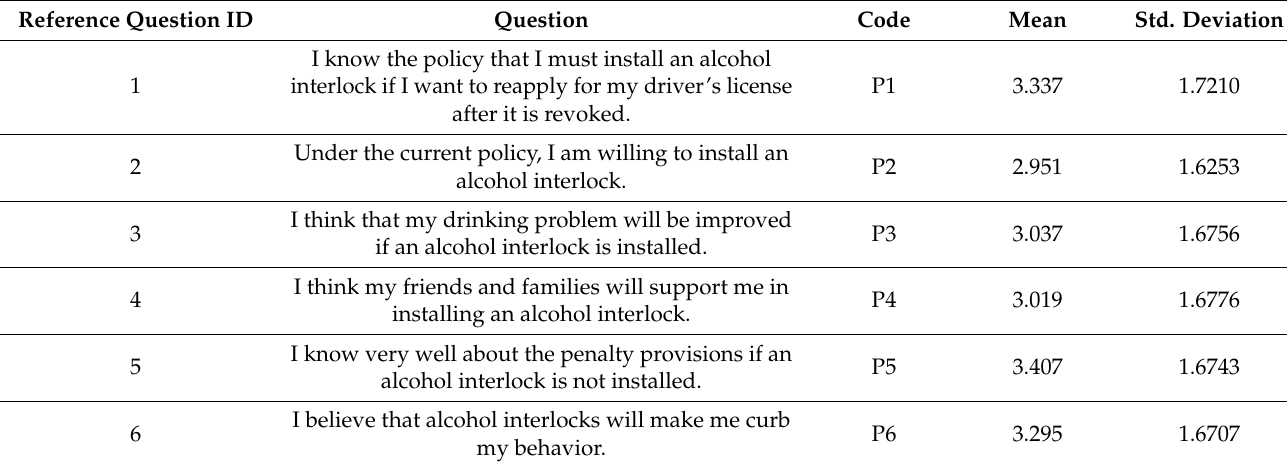
Table 3. Descriptive statistics of questions on attitude towards alcohol interlock and reference question